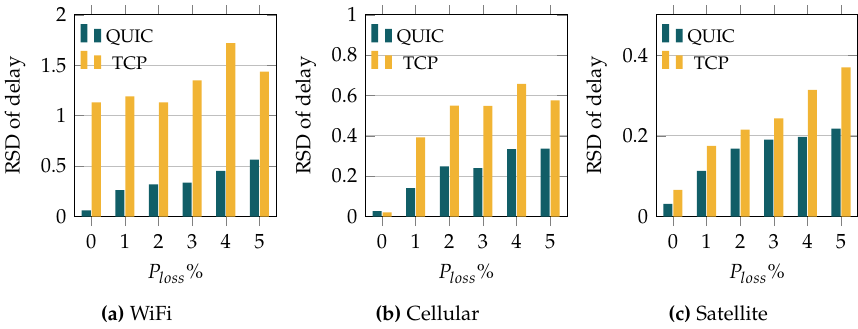
Figure 7. Delay RSD observed with QUIC and TCP over the different wireless technologies.